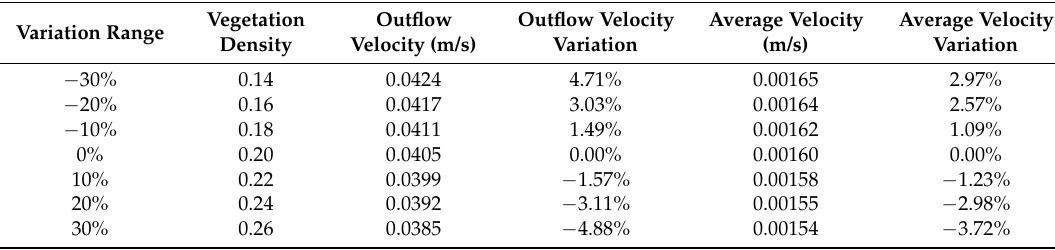
Table 3. Effect of vegetation density on flow